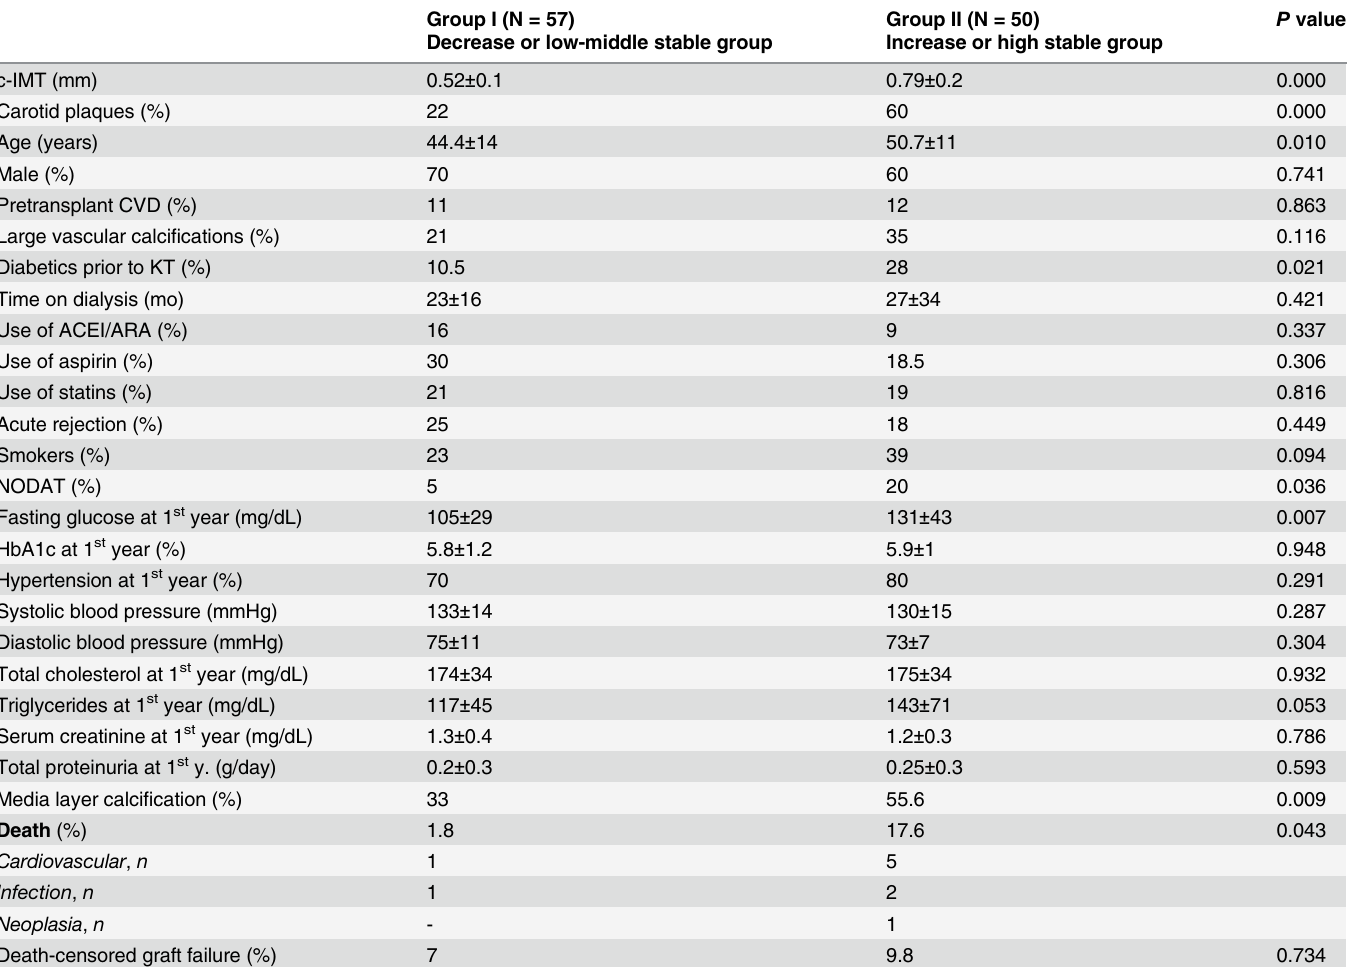
Table 3. Clinical characteristics of patients after stratification according to c-IMT measurement variation after second carotid echographic study. Group I (N = 57) Group II (N =